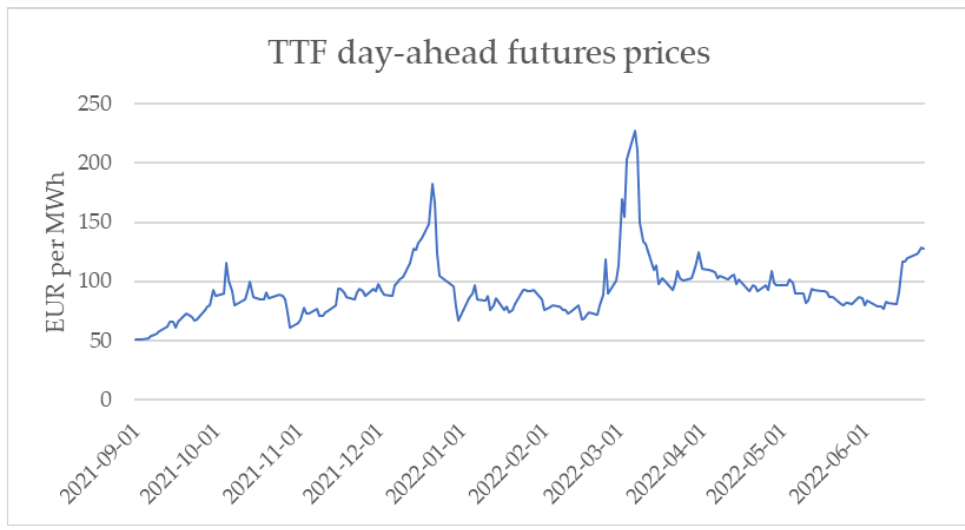
Figure 6. Day-ahead TTF gas price, 1 September 2021–23 June 2022. Source: [11].